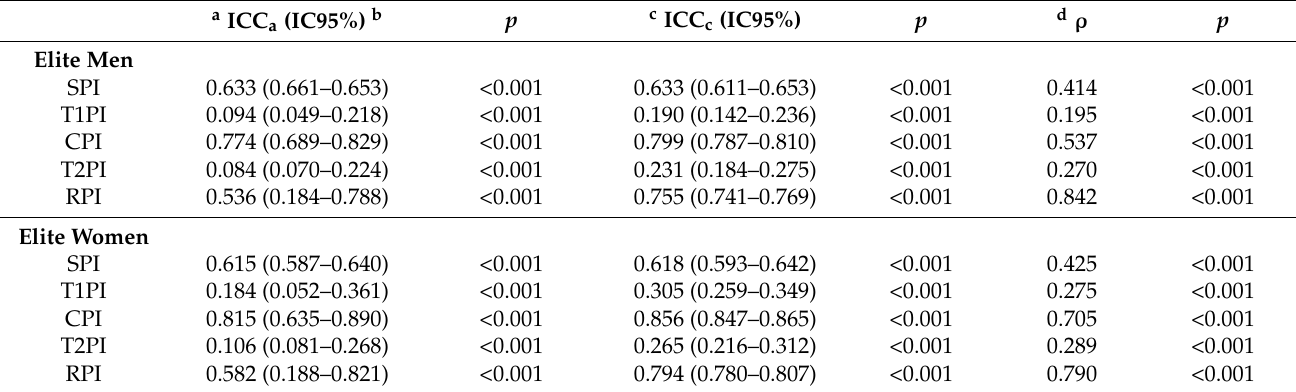
Table 3. Random selection of the subsample representing 75% of the total